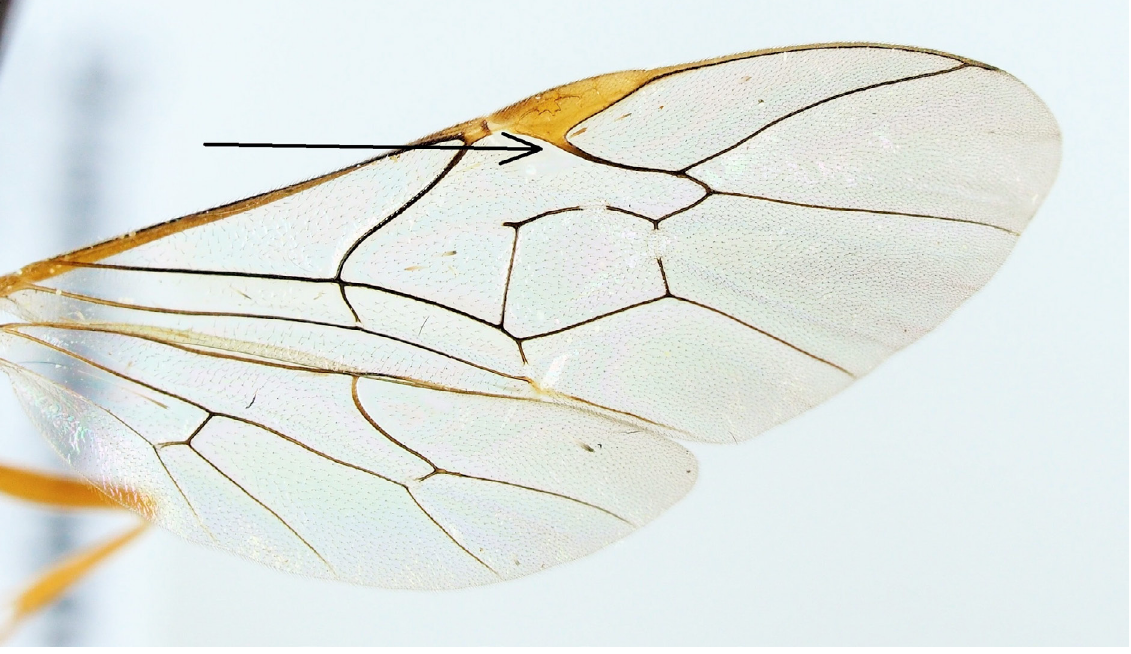
Fig. 12. right wings: Ophion minutus Kriechbaumer, 1879, female. Junction between Rs + 2r and pterostigma